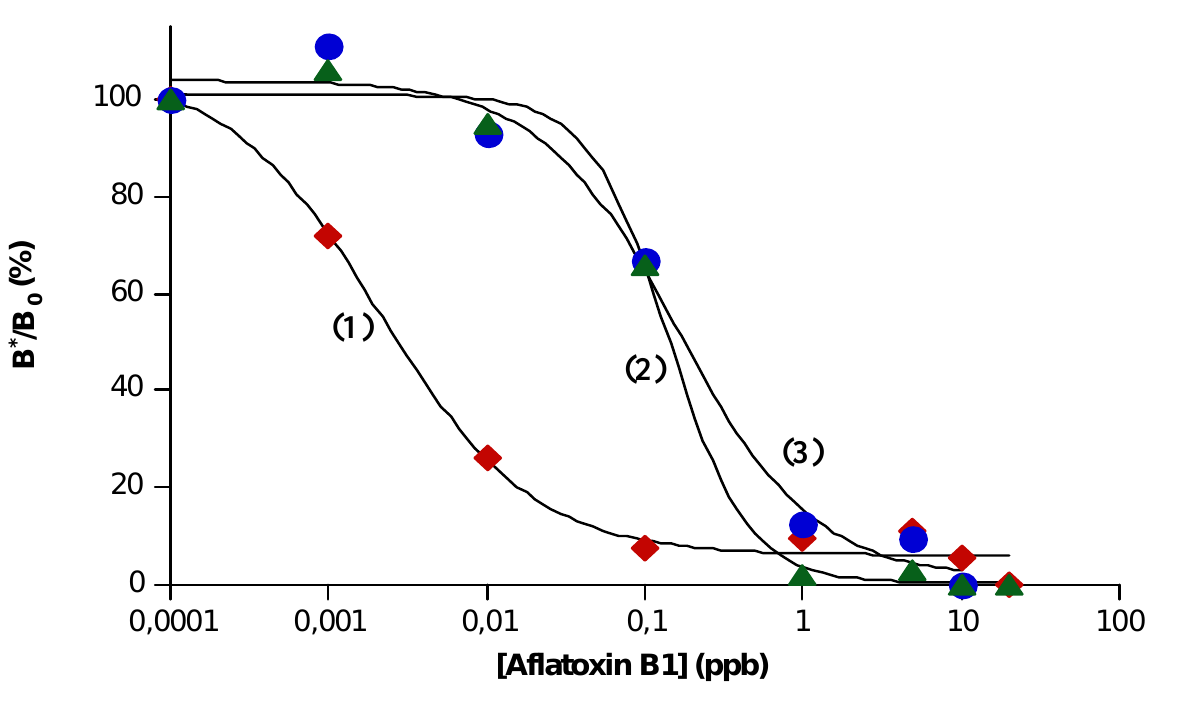
Figure 2. Dilution curves of Aflatoxin B1 for different immobilization procedures of the antibody on the magnetic particles surface: (1) covalent immobilization; (2) affinity immobilization via protein A; (3) affinity immobilization via protein G. Experimental conditions: 1:1000 dilution grade of Ab III-bead suspension and 1:100 dilution grade of is the rate of the signal corresponding to bond fraction of the tracer and zero tracer). (B*/B 0 dose.)